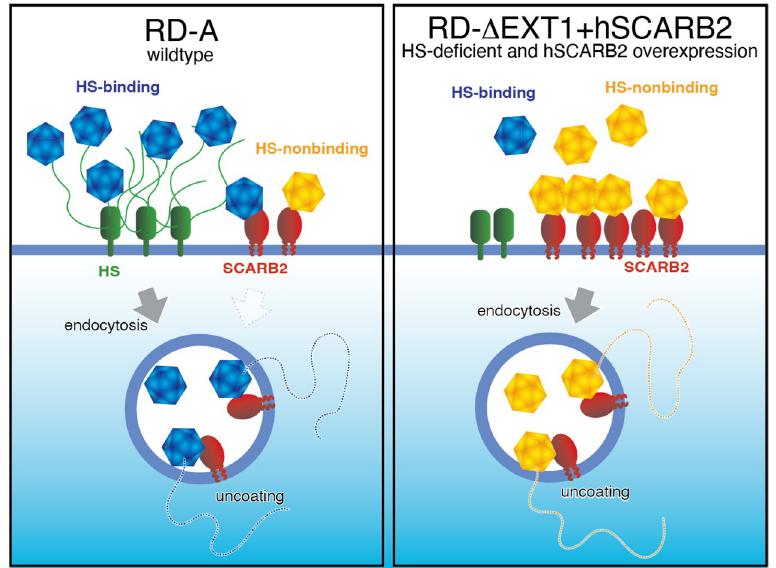
Figure 1. Selective infection of cultured cells by HS-binding mutants. (Left panel) Normal cell lines, such as RD-A, show low cell surface expression of SCARB2 and high expression of HS. Therefore, the infection efficiency of wild-type HS-nonbinding mutants is low. By contrast, a small number of HS-binding mutants emerge during replication and efficiently infect cells through HS; thus, HS- binding mutants become dominant. (Right panel) In RD-∆EXT1+hSCARB2 cells, selective infection by HS-binding mutants is less likely to occur because the expression of SCARB2 and HS, responsible for such infection bias, is